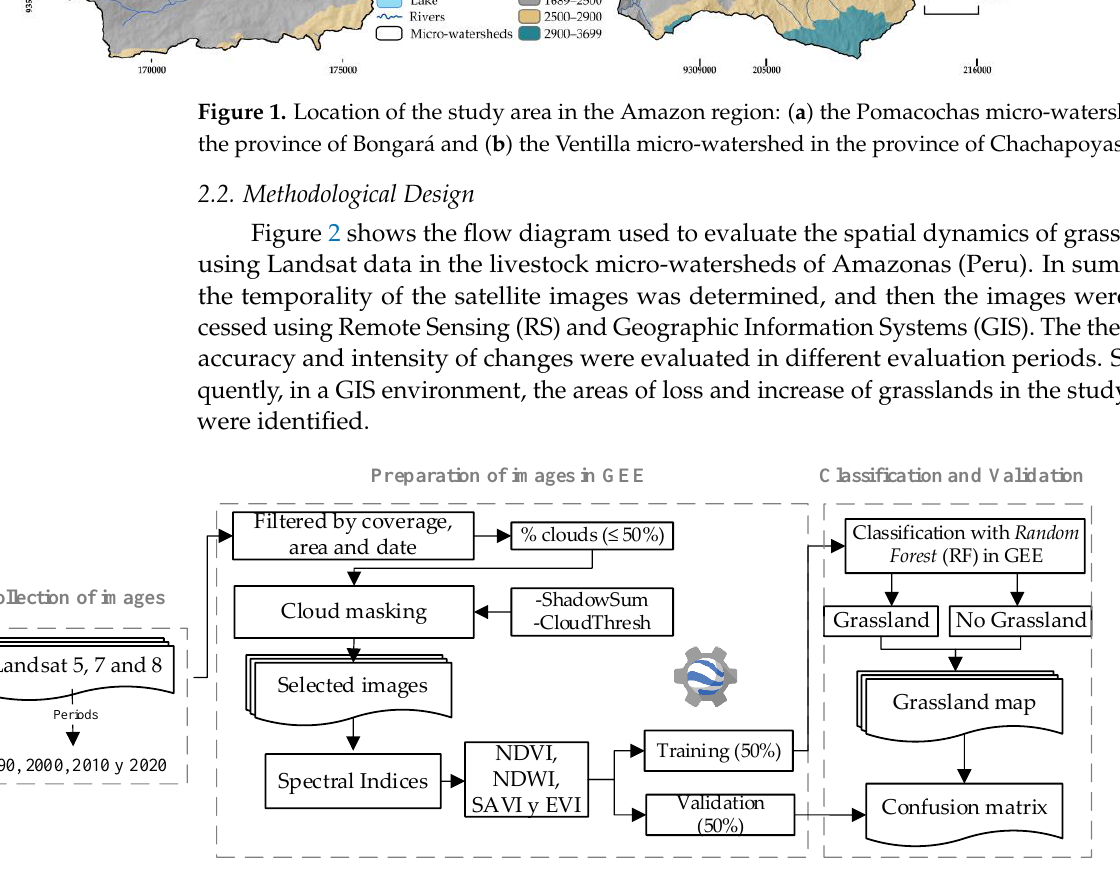
Figure 2. Methodological flowchart used to evaluate the spatial dynamics of grasslands using Land- sat data in livestock micro-watersheds of Amazonas (Peru).